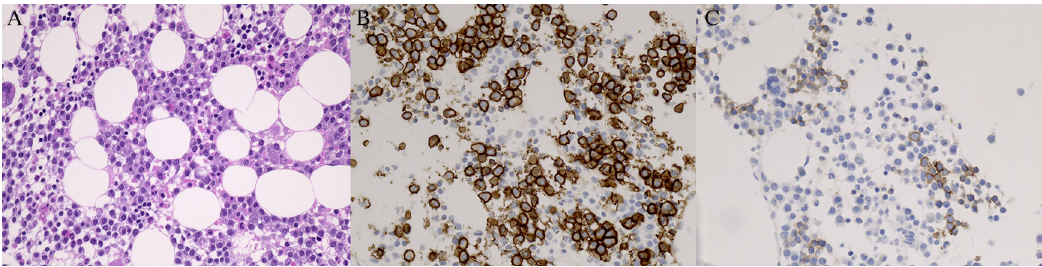
Figure 1. Typical immunophenotype of E-cadherin-positive MM cells (original magnification (cid:3) 400). (A) BM biopsy with MM cell infiltrate. Hematoxylin and eosin stain. Consecutive sections of BM biopsies were stained with